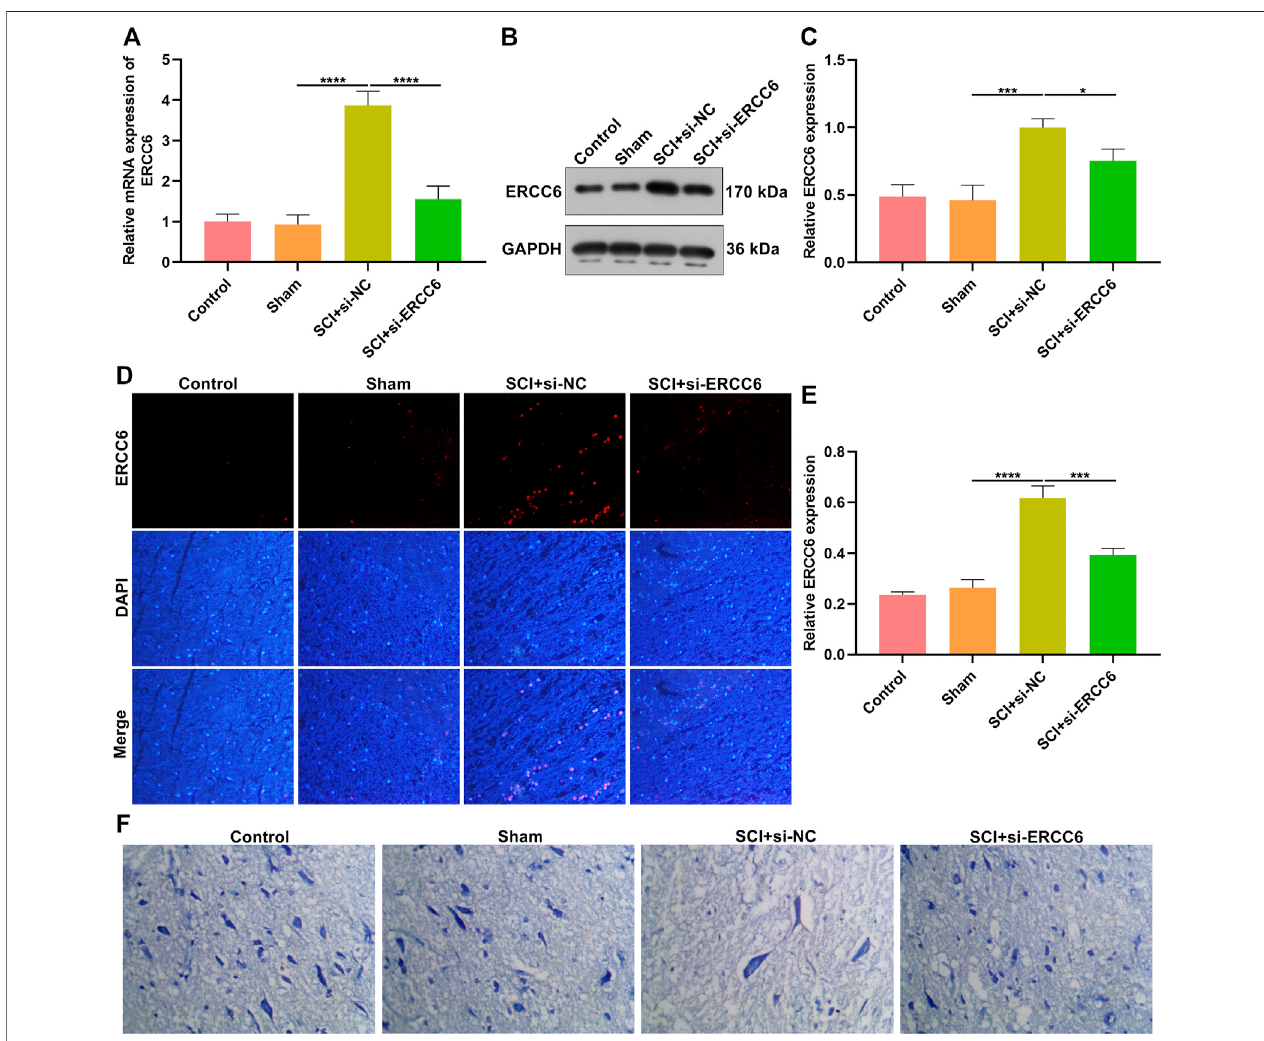
FIGURE2| ERCC6knockdownalleviatesneuronaldamageintheICImice. (A) RT-qPCRanalysisofERCC6expressioninthespinalcordofSCImiceinjectedwith si-ERCC6 or si-NC as well as control and sham operation mice. (B,C) Western blotting analysis of ERCC6 expression in the damaged spinal cord of mouse models injected by si-ERCC6 or si-NC as well as control and sham operation mice. (D,E) Immuno fl uorescence staining of ERCC6 expression in the damaged spinal cord of mouse models injected by si-ERCC6 or si-NC as well as control and sham operation mice (scale bar, 50 μ m). (F) Nissl staining of spinal cord sections of SCI mice injectedwithsi-ERCC6orsi-NCaswellascontrolandshamoperationmice(scalebar,50 μ m;N=8miceineachgroup). p -valueswerecalculatedwiththeANOVAtest. * p -value < 0.05; *** p -value < 0.001; **** p -value <